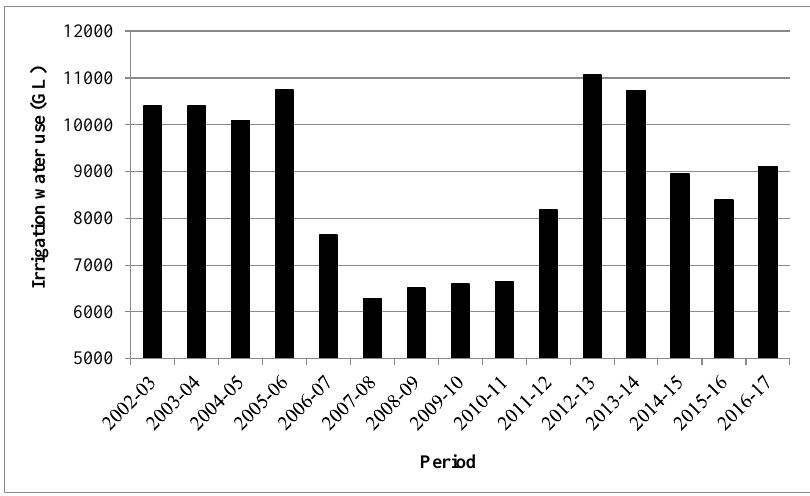
Figure 5. Total irrigation water use in Australia. (Plotted from data obtained from: Australian Bureau of Statistics (ABS),